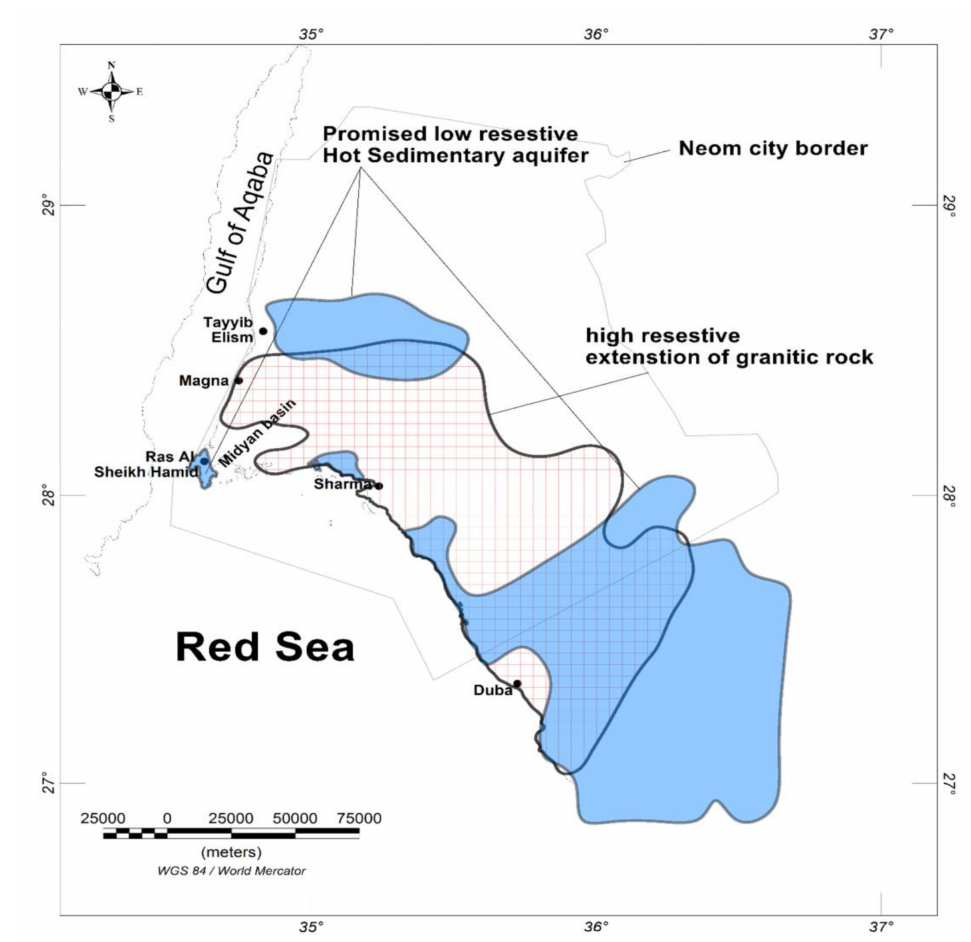
Figure 8. Final interpretation map showing the most promised zones (blue-filled polygons) for hot sedimentary basins and high-heat granitic rocks (red crossed